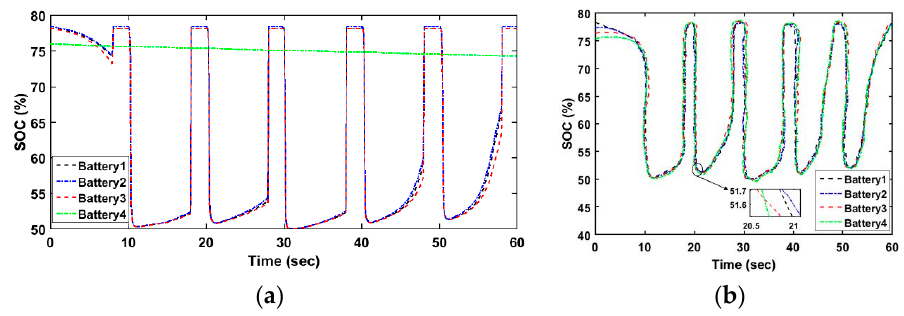
Figure 18. Individual batteries SOC ( a ) without and ( b ) with the proposed method.